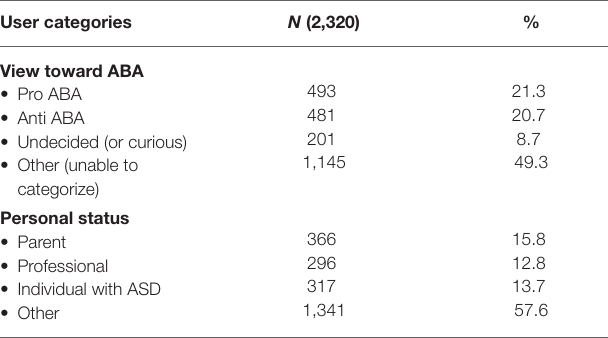
TABLE 1 | Reddit user categories.